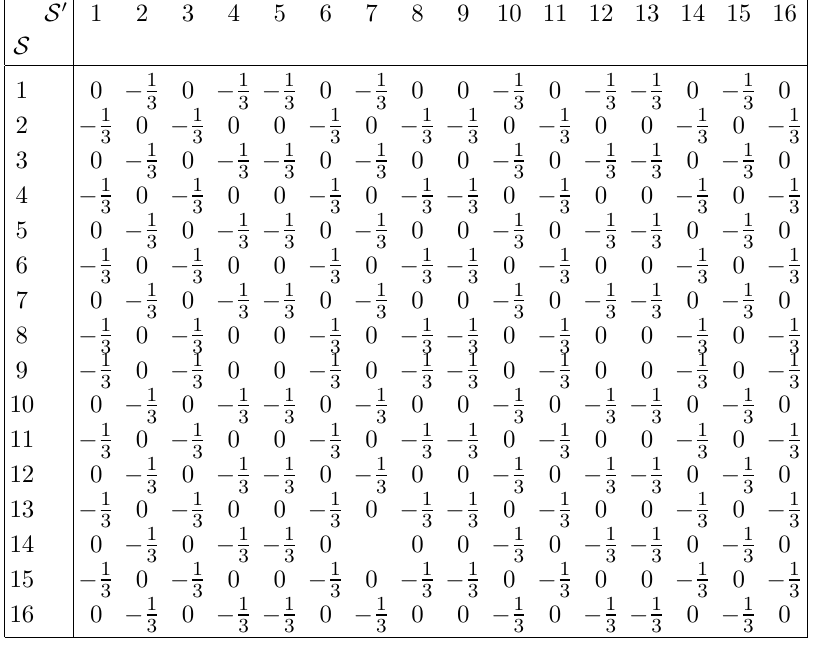
(cid:2) P with di(cid:11)erent boolean factors. [3] [4]